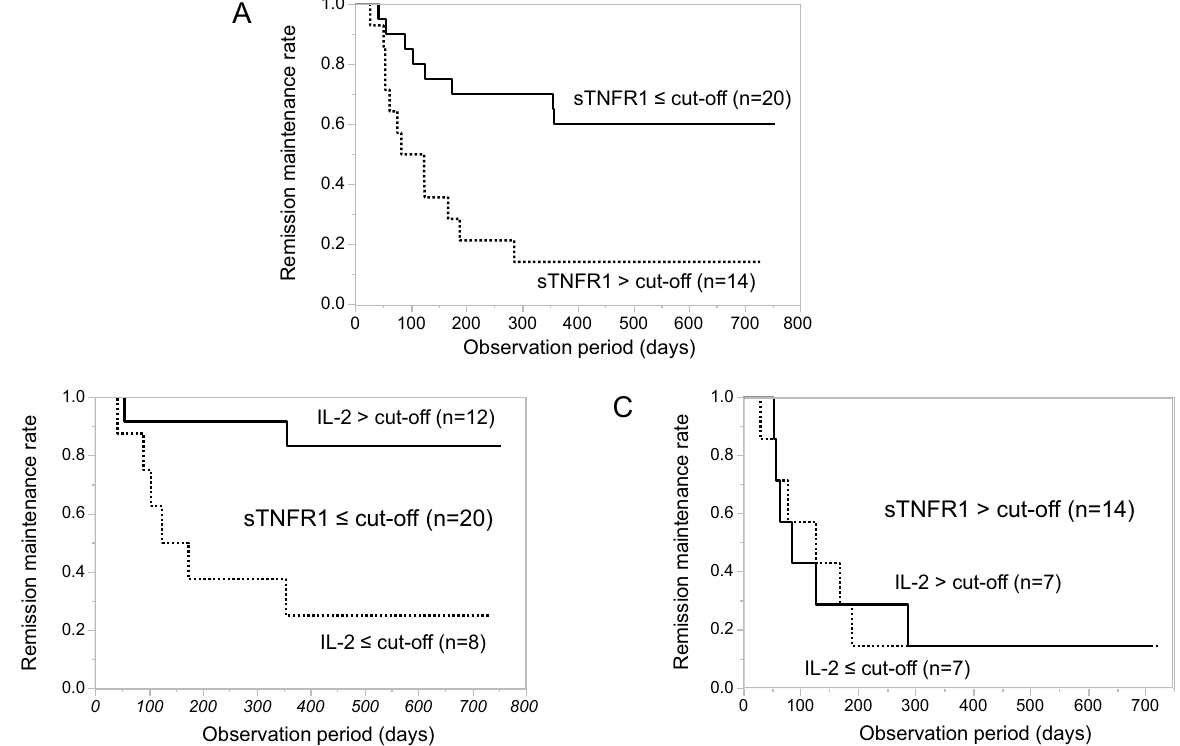
Figure 3. Plasma cytokine profile at baseline as a predictive marker of RA flare after bDMARD discontinuation. ( A ) Comparison of patients with sTNFR1 ≤ cut-off (n = 20, solid line) and sTNFR1 > cut-off (n = 14, dotted line). ( B ) Comparison of patients with IL-2 > cut-off (n = 12, solid line) and IL-2 ≤ cut-off (n = 8, dotted line) in those with sTNFR1 ≤ cut-off (n = 20). ( C ) Comparison of patients with IL-2 > cut-off (n = 7, solid line) and IL-2 ≤ cut-off (n = 7, dotted line) in those with sTNFR1 > cut-off (n = 14). bDMARD biological disease-modifying antirheumatic drug, RA rheumatoid arthritis, sTNFR1 soluble tumour necrosis factor receptor 1, IL